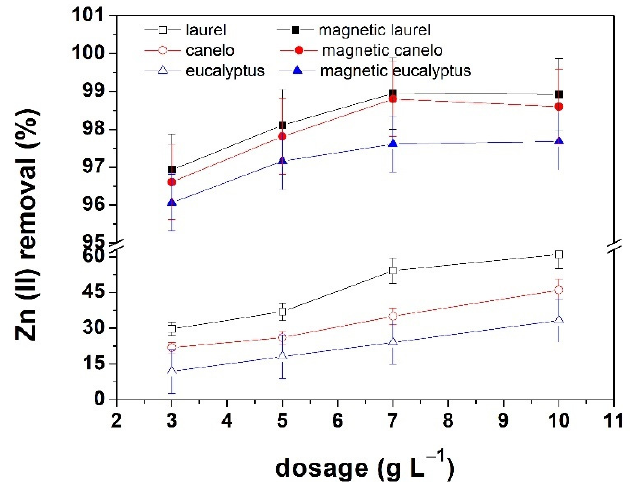
Figure 5. Contact time effect on zinc removal using magnetic composites.